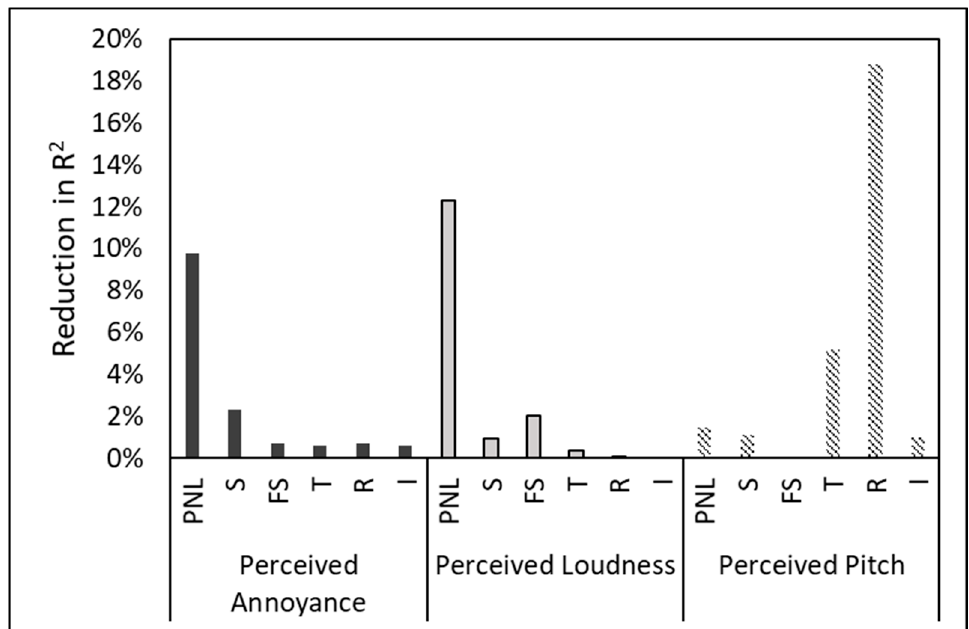
Figure 5 . Reduction in R 2 per predictor removed from multilevel model (using subject-dependent intercepts and regression slopes) for perceived annoyance, loudness and pitch.